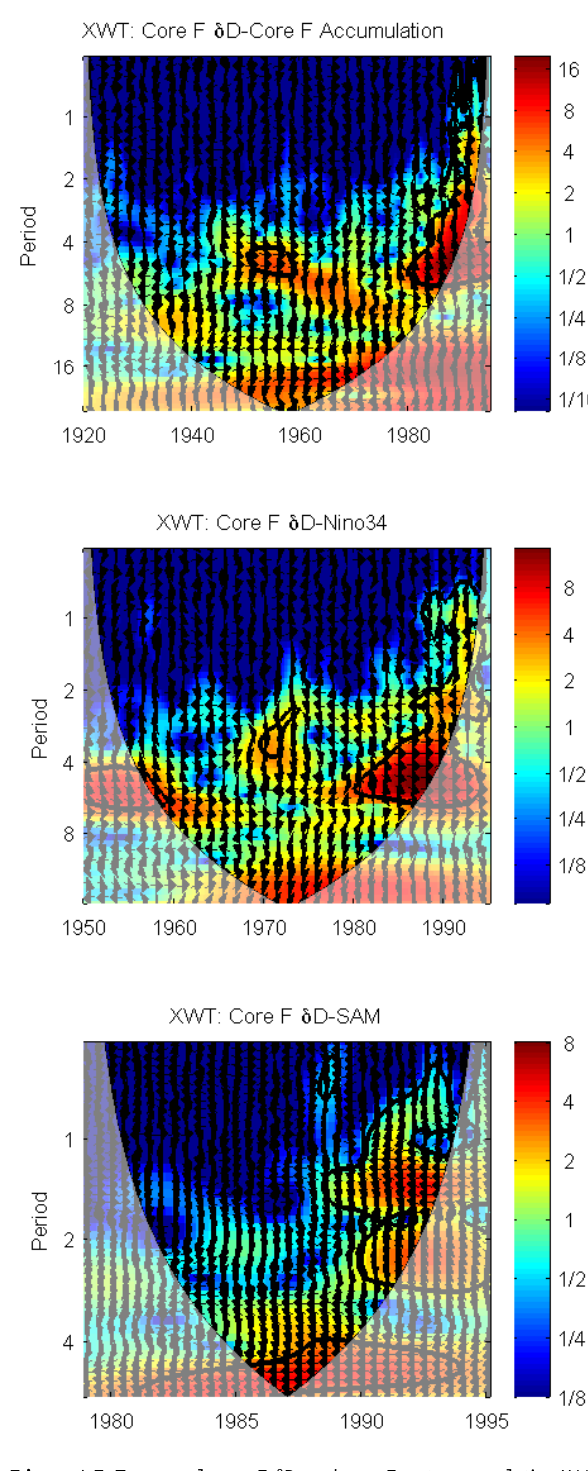
Figure A.7. Top) Core F δ D and Core F Net Accumulation XWT from 1657-1995. Middle) Core F δ D and Ni˜no 3.4 XWT from 1950-1995. Bottom) Core F δ D and SAM XWT from 1979-1995. J. Name